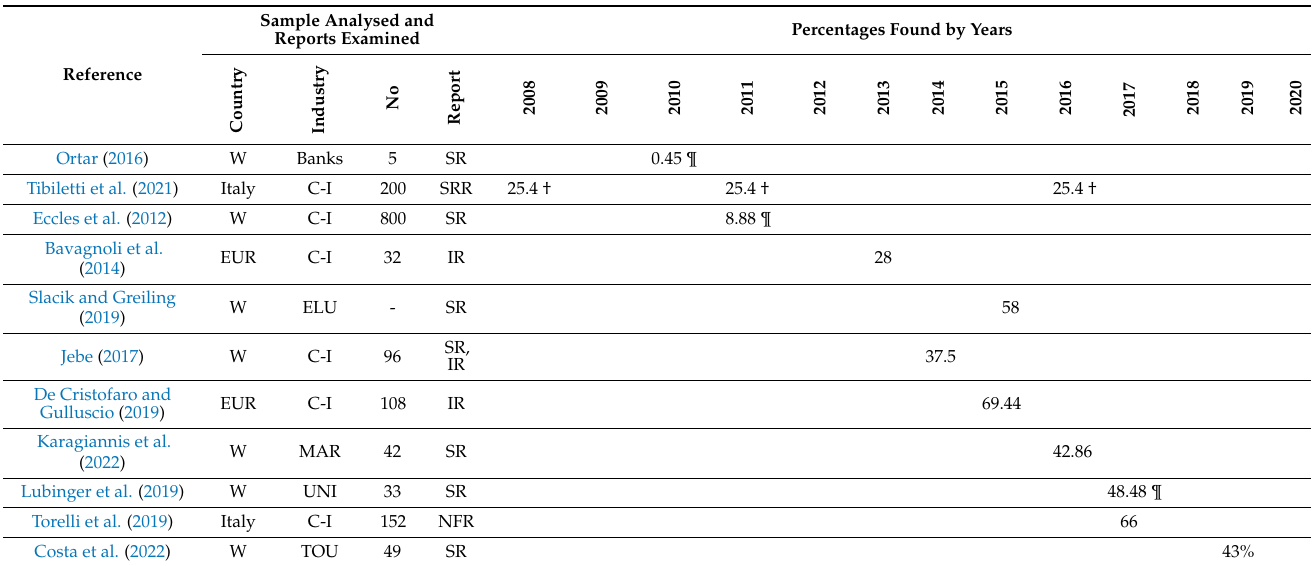
Table 1. Empirical findings on materiality matrix adoption in existent sample-based works